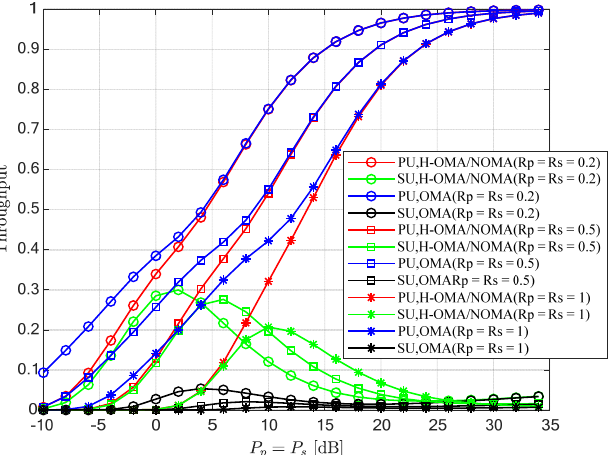
Figure 6. Throughput vs PU’s transmit power 𝑃 (cid:3017) with different data rate 𝑅 (cid:3017) and 𝑅 (cid:3020) .